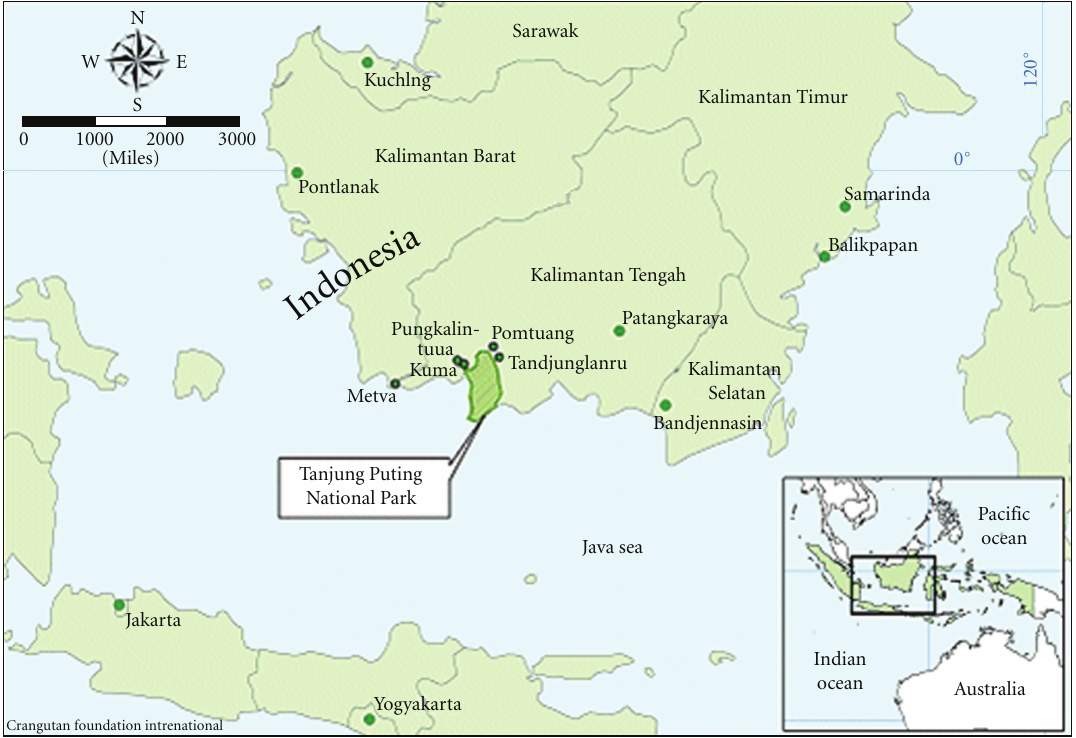
Figure 1: Map of Tanjung Puting National Park (reprinted from Galdikov and Shapiro 1994; courtesy: Orangutan Foundation International). Weather station 966450 (WRBI) is located at ( − 2 ◦ 7 (cid:3) , 111 ◦ 7 (cid:3) ), elevation 25 meters, near the NorthEastern tip of the National